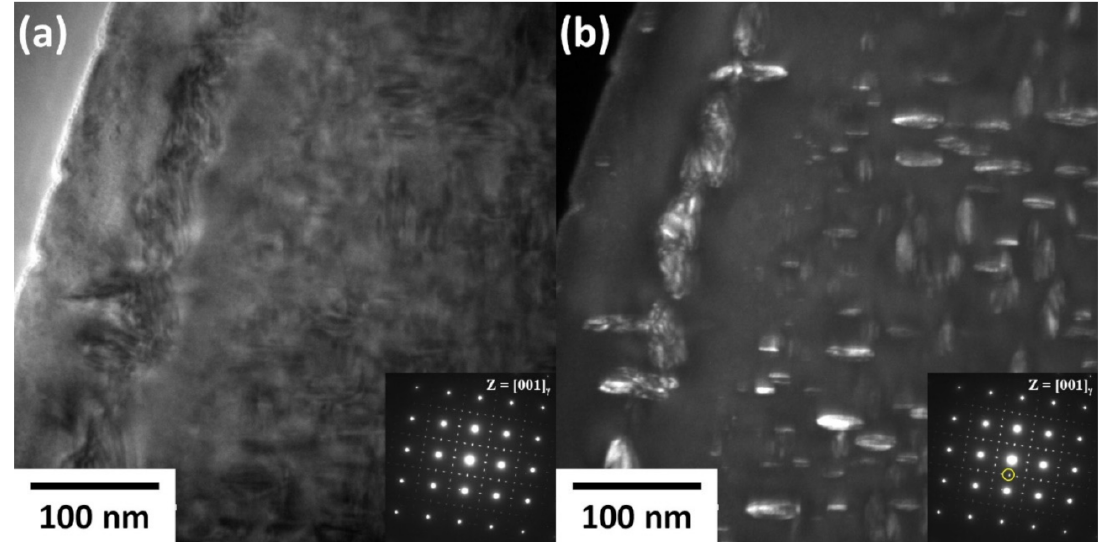
Figure 5. TEM images of as-built specimen were taken from the [001] zone axis, showing nano-scale γ ’/ γ ” precipitates—( a ) bright-field image, ( b ) dark-field